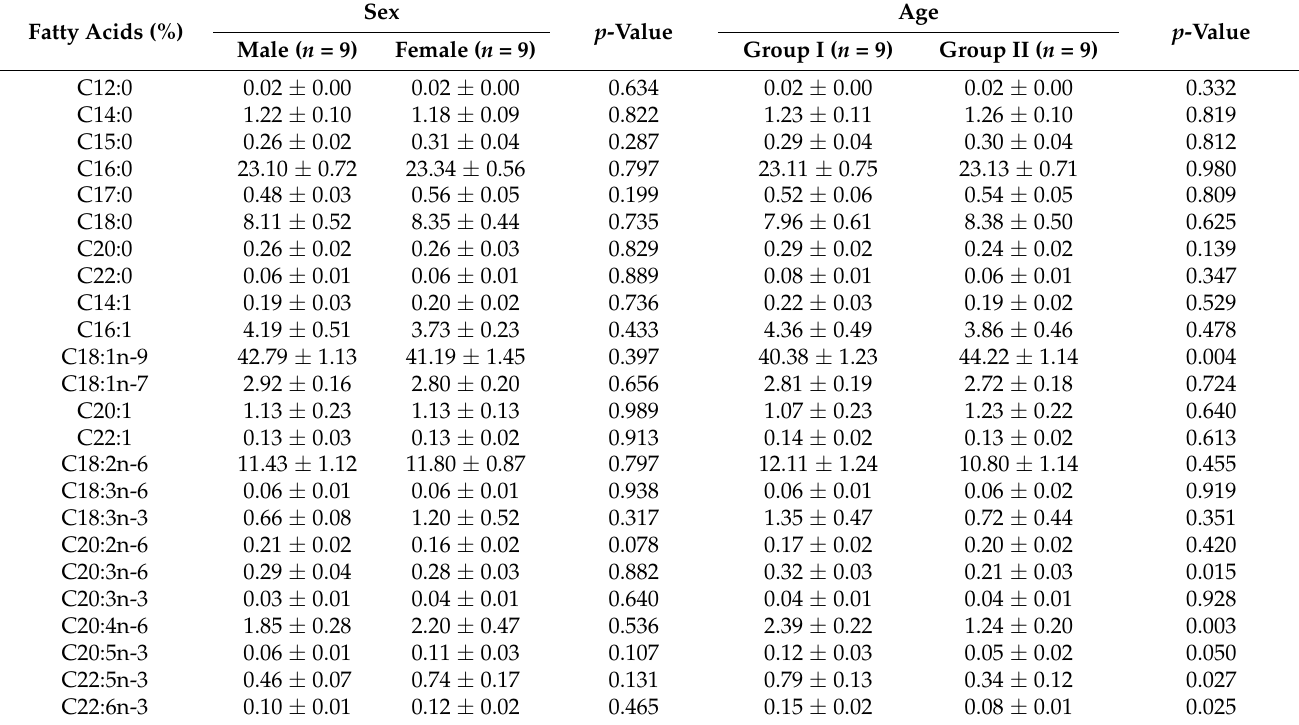
Table 2. Fatty acid composition of the brown bear, M. semimembranosus , as influenced by sex and age groups (mean ± SE). Fatty Acids